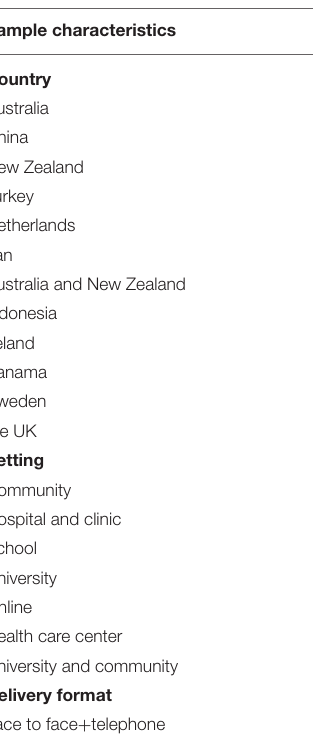
TABLE 1 | Study characteristics of the included